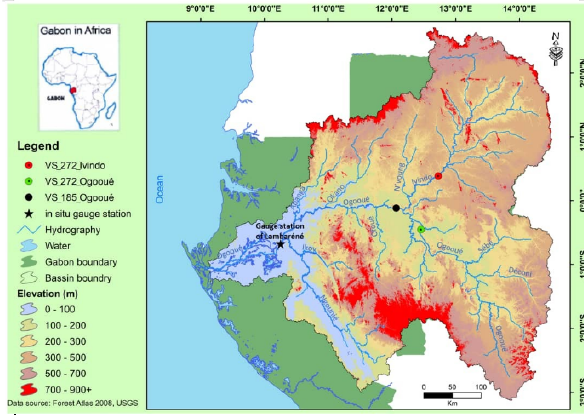
Figure 1. Topography and main rivers of the